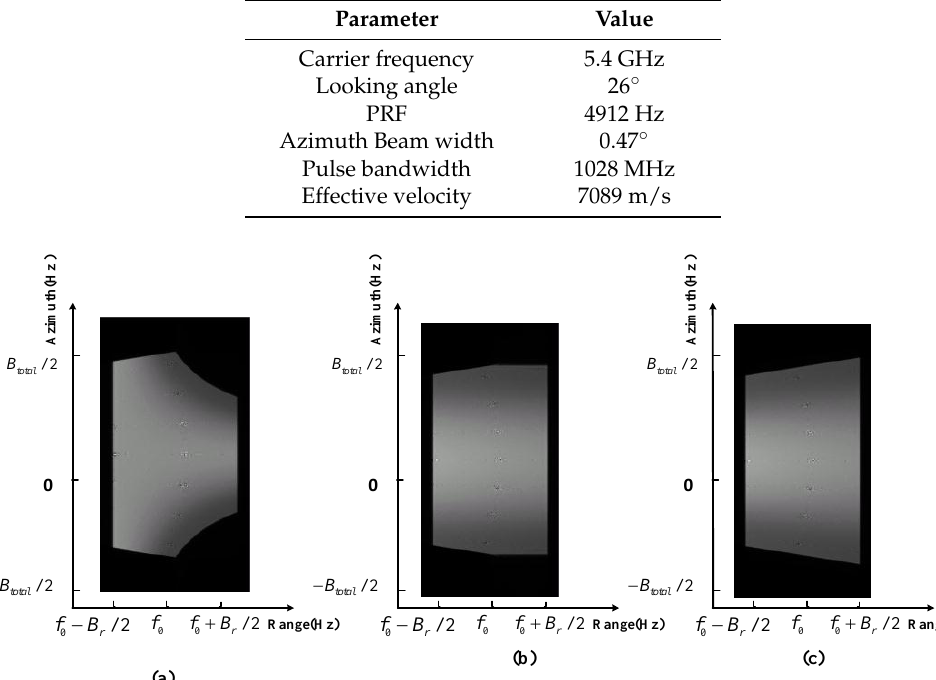
Figure 14. The comparison of two dimensional spectrum of a single target at 0.3 m resolution using different azimuth weighting methods. ( a ) Conducting azimuth weighting in the range time domain; ( b ) Conducting azimuth weighting in the range frequency domain without updating f r ;